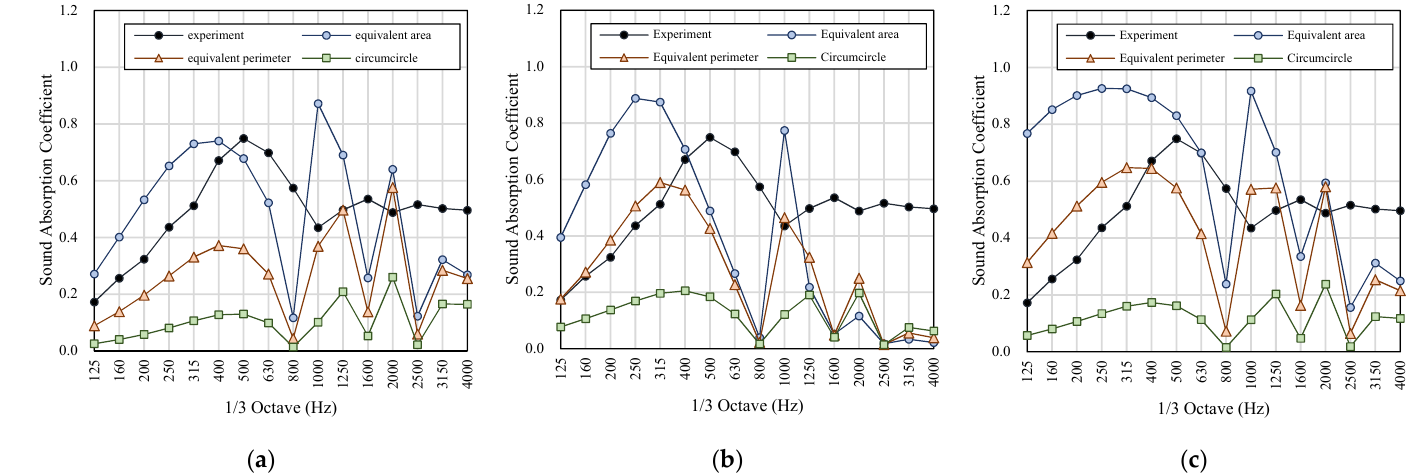
Figure 7. Comparison of the different methods to the converted orifice diameter (using the small side condition): case E1. ( a ) Semi-theoretical model; ( b ) Lee & Kwon’s model; ( c ) Maa’s model.